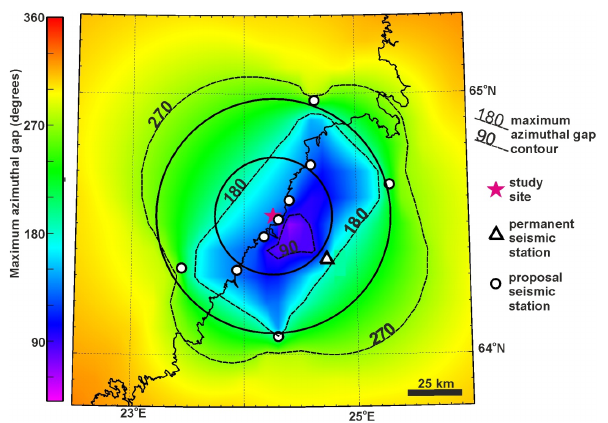
Figure 4. A map of the maximum azimuthal gap (AG) within a ten station network. 2 Fig. 4. A map of the maximum azimuthal gap (AG) within a ten Concentric circles around the site show the survey area 3 station network. Concentric circles around the site show the survey area.